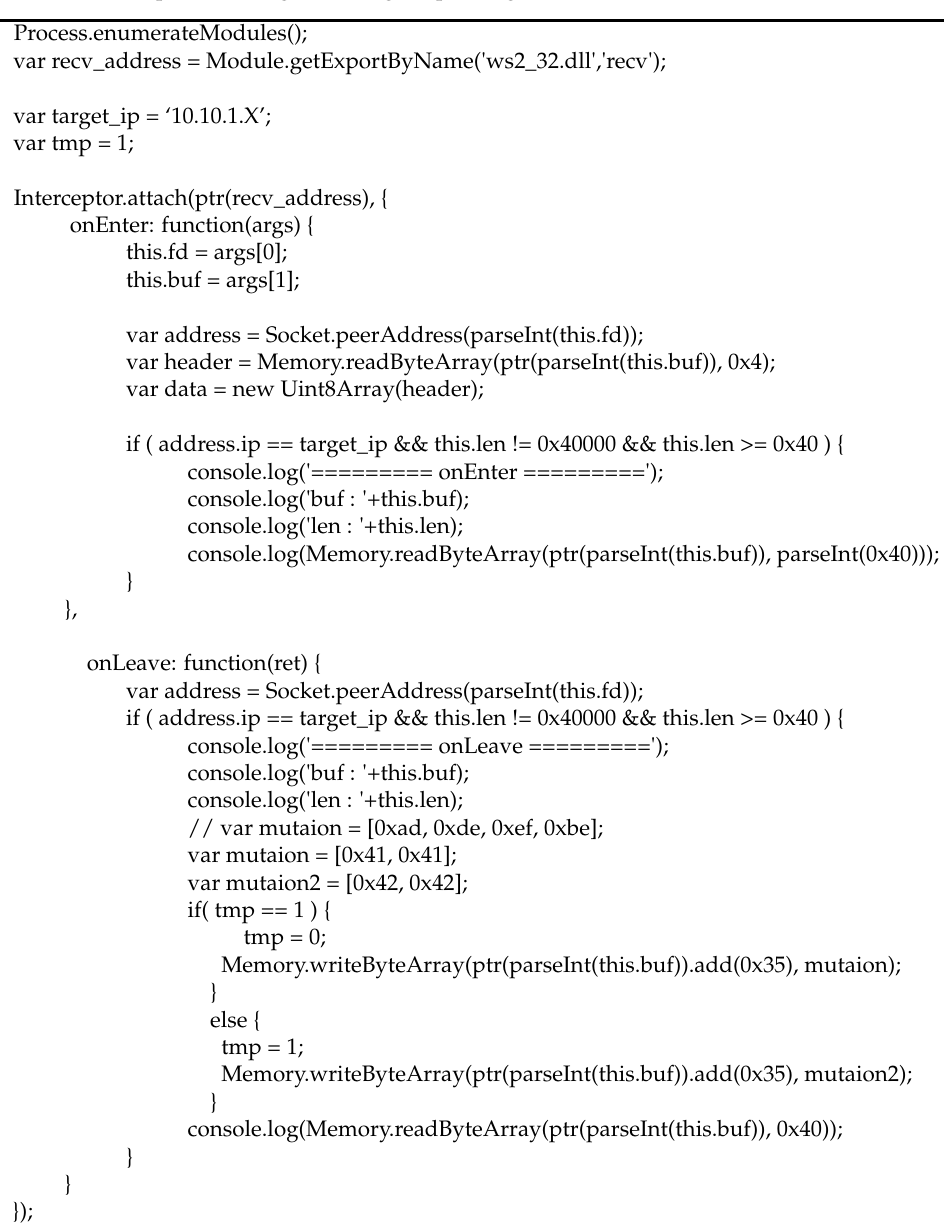
Table A3. Example of writing a hooking script using